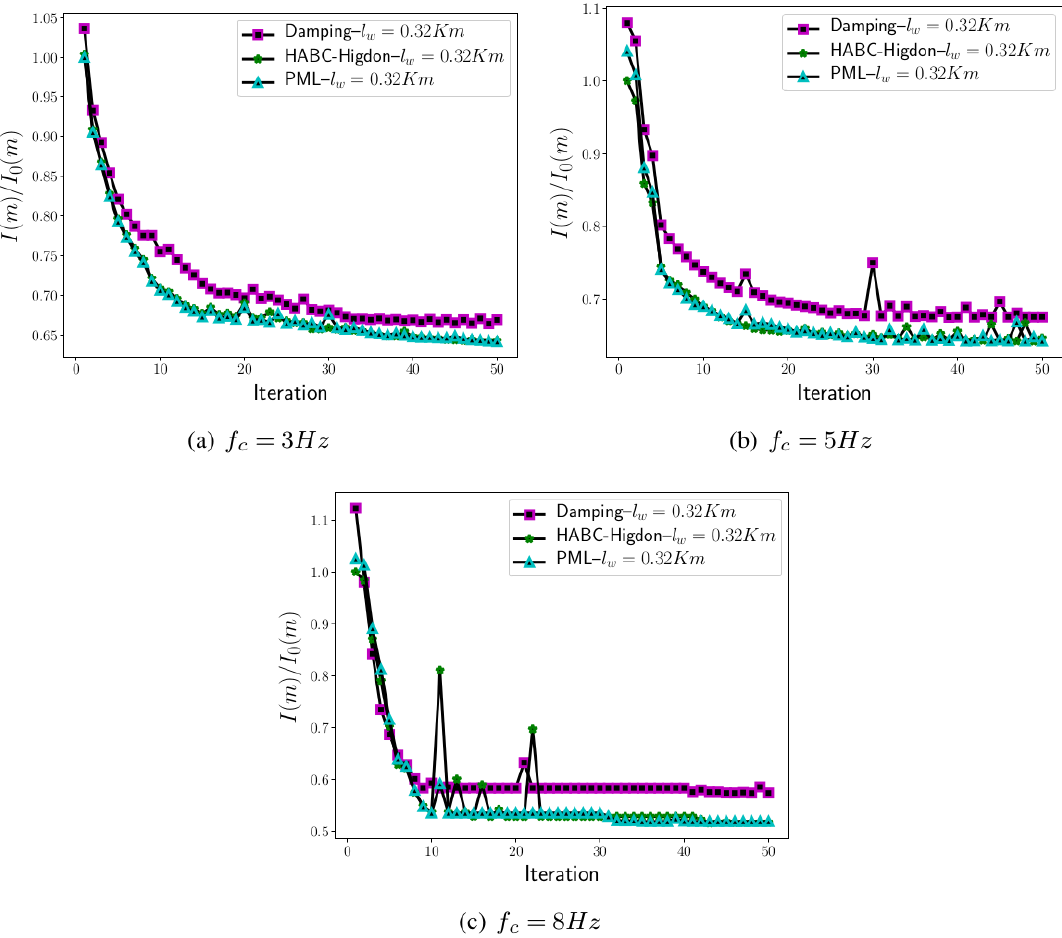
Figure 17. Comparisons of the misfit values I(m)/I 0 (m) for a velocity model computation that is then matched with Marmousi, where the peak of frequency is f 0 = 15Hz, and a multiscale approach in frequency (Bunks et al., 1995) is employed. I 0 (m) is computed at the first iteration, which is the minimal misfit value given by the employment of the damping, HABC-Higdon, and PML